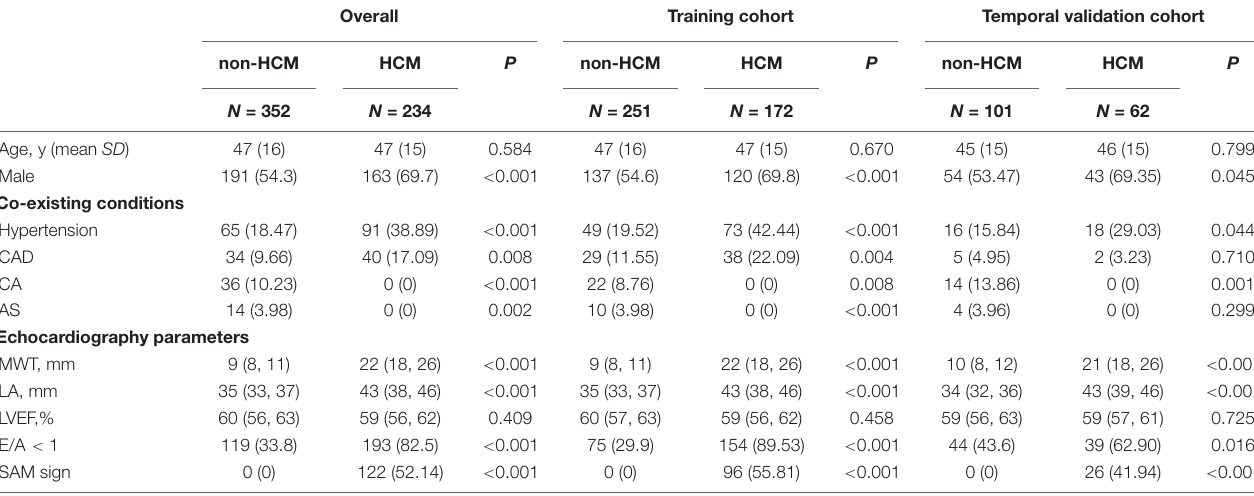
TABLE 1 | Baseline